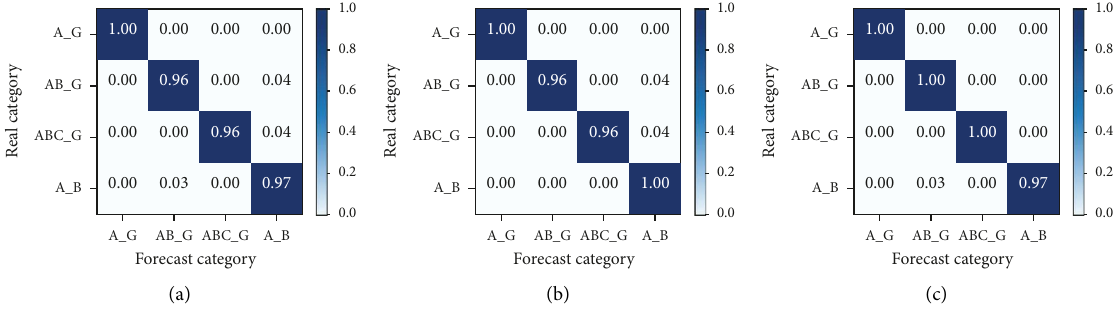
Figure 9: Confusion matrices for the network model. (a) 1DCNN network. (b) 1D-LSTM network. (c) 1DCNN-BiLSTM network. Table 4: Accuracy comparison of diferent network models. Network